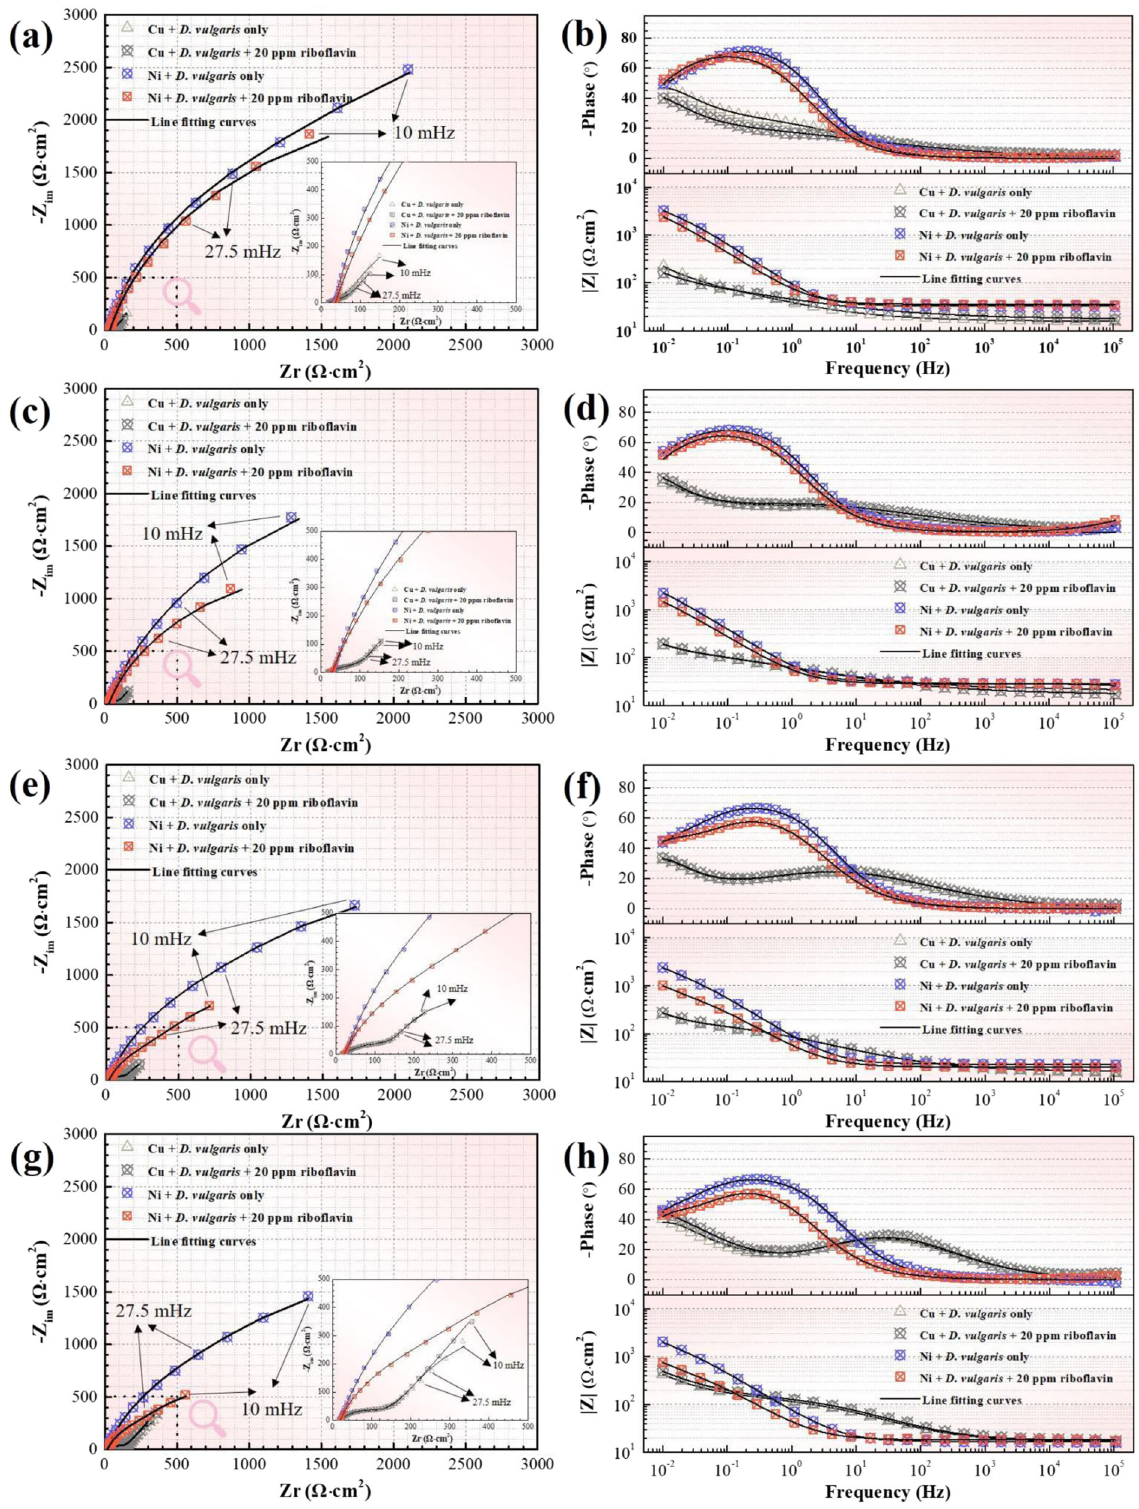
Fig. 11 EIS. Nyquist and Bode plots of Cu and Ni coupons during the 7-d incubation in the D. vulgaris media without and with ribo fl avin: 1-d ( a , b ), 3-d ( c , d ), 5-d ( e , f ), and 7-d ( g , h